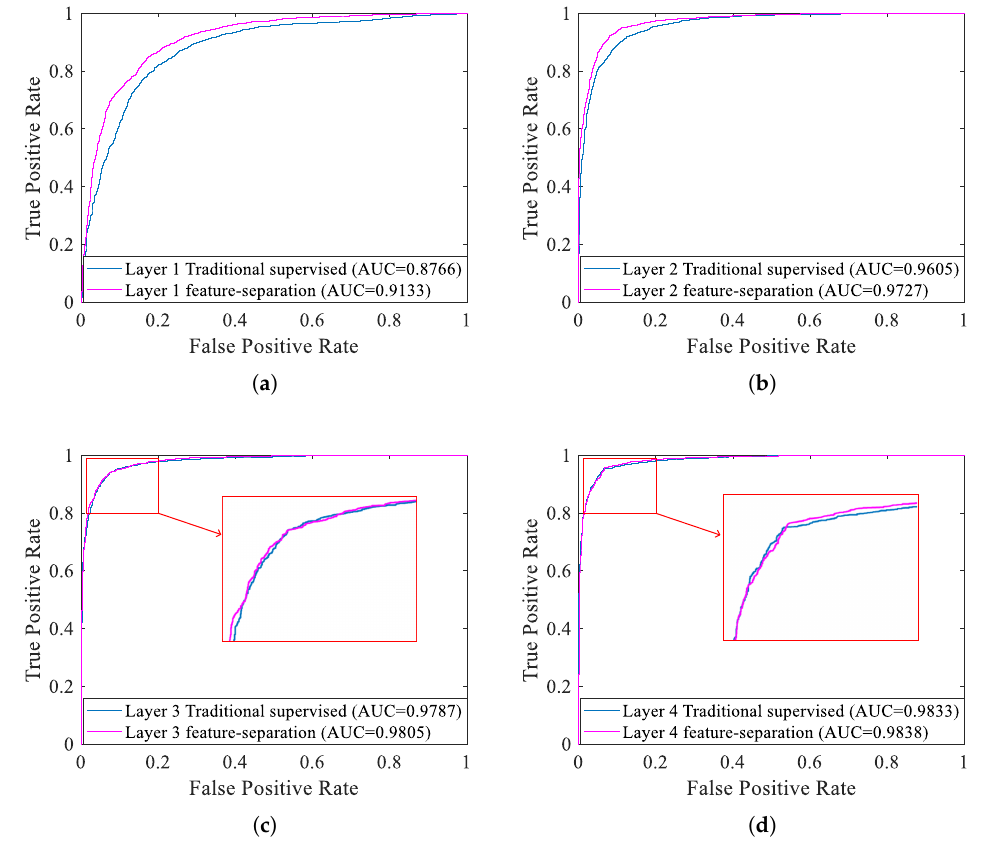
Figure 19. ROC curves of each layer after fine-tuning with the traditional supervised training algorithm and with the supervised feature-separation algorithm. ( a ) Layer 1. ( b ) Layer 2. ( c ) Layer 3. ( d ) Layer